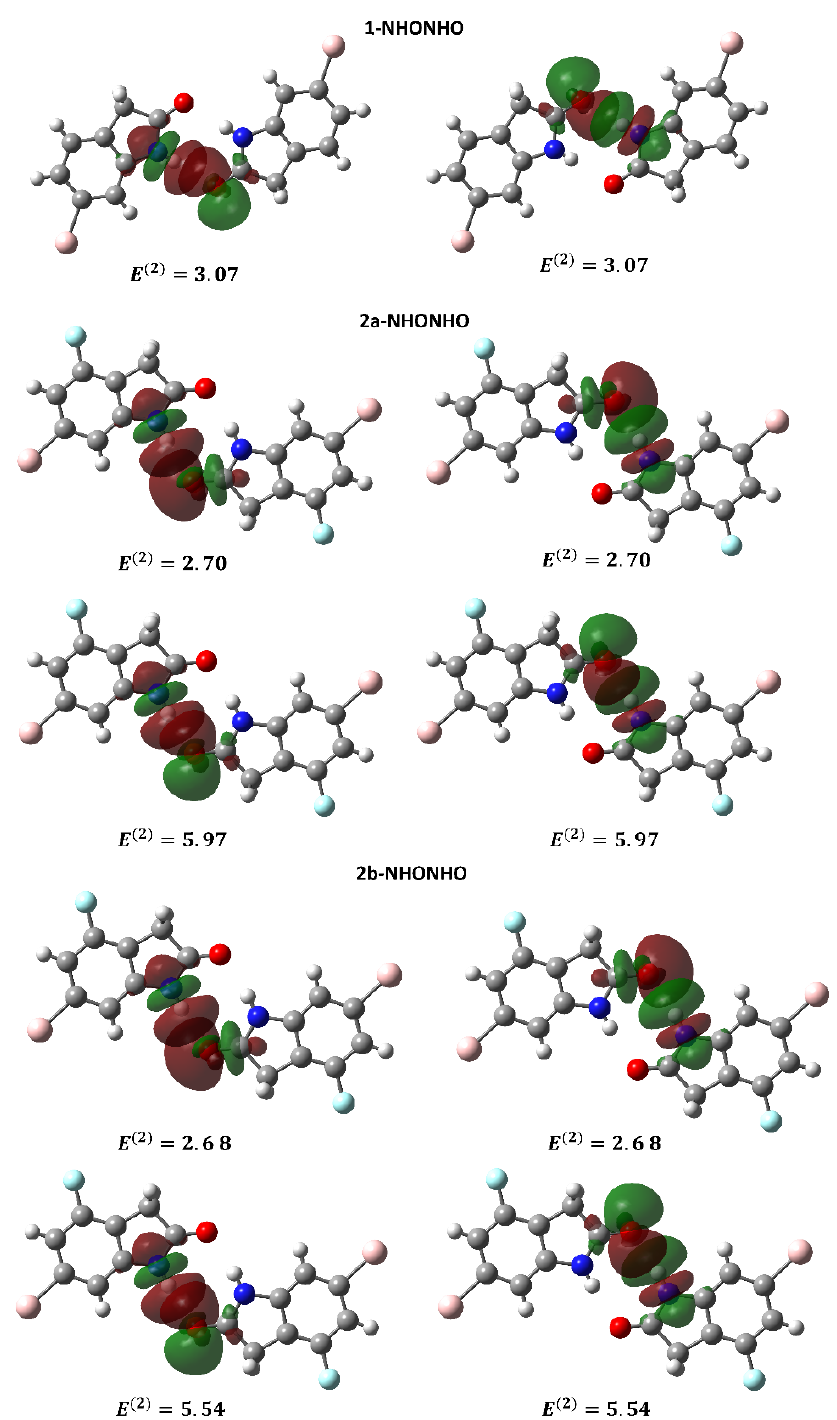
Figure 8. NBO donor and acceptor orbitals for dimers of 1 and 2 obtained with the MP2/def2-TZVP theory level. The NBO second-order energy perturbation (cid:1831) ((cid:2870)) is given in kcal/mol. The threshold of 0.10 kcal/mol was employed for the NBO orbital printing. Phase relationships between donor and acceptor NBO orbitals are